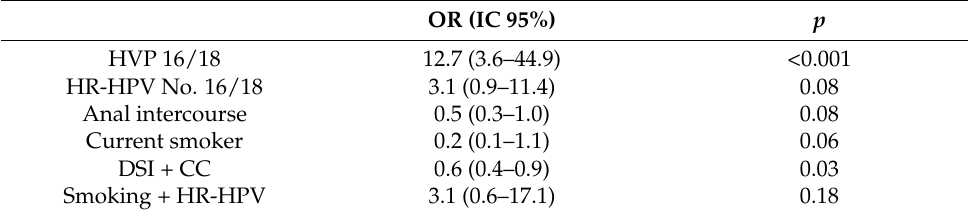
Table 3. Logistic regression model of the relevant factors ( p < 0.1) in the univariate analysis. OR (IC 95%)